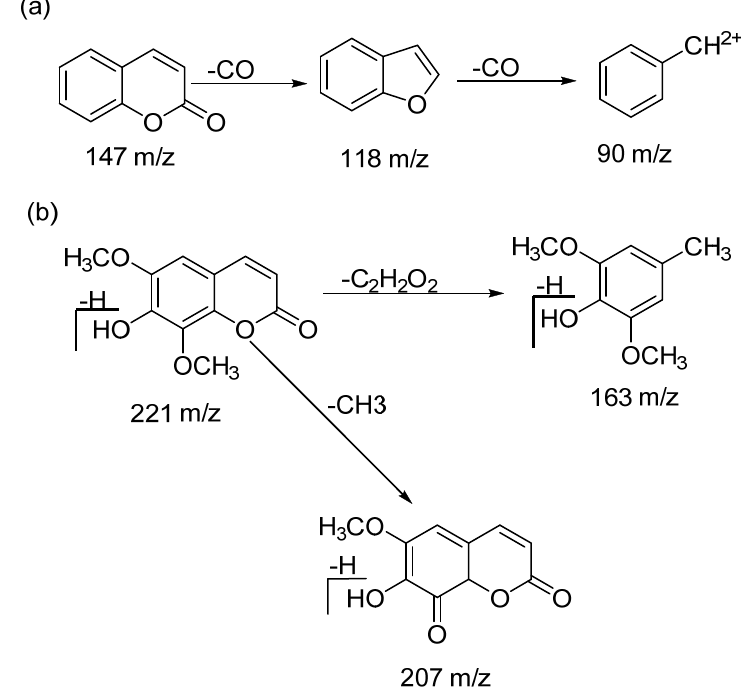
Figure 3. Mass fragmentation pattern of coumarin basic structure ( a ) and IF ( b ).